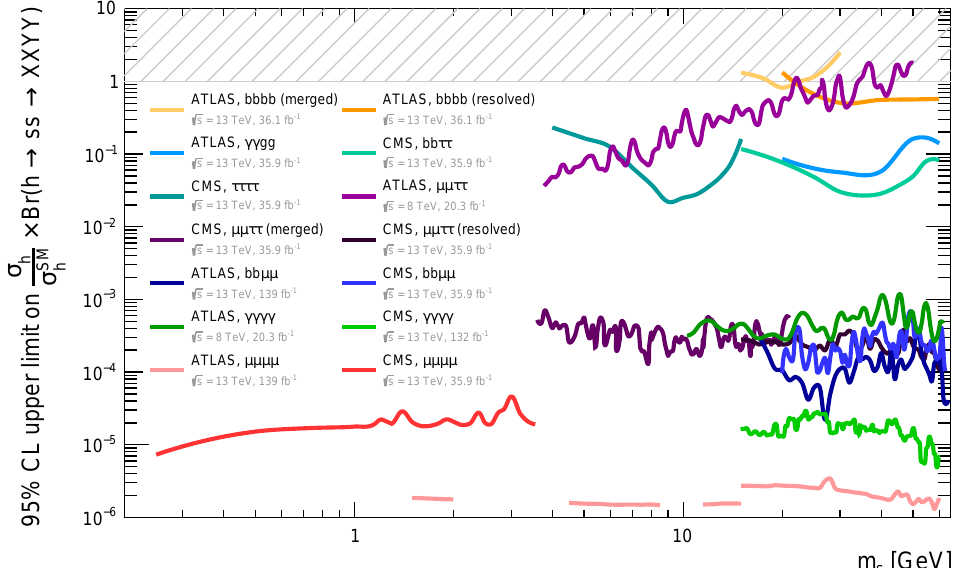
Figure 1. Limits on the process in Equation (1), taken from [11]. This displays current constraints which can especially be easily reinterpreted in extended scalar sector models, in particular models where couplings are inherited via a simple mixing angle. In this figure, the lighter scalar is denoted by s , which corresponds to h i in the notation used in this